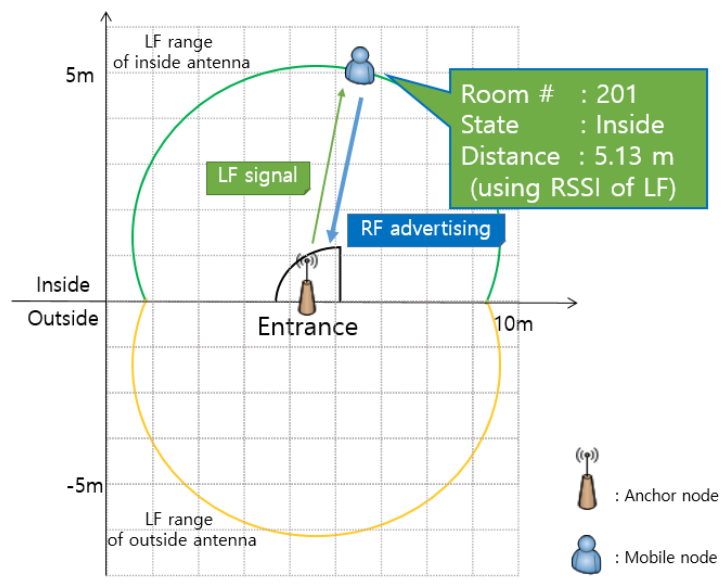
Figure 4. Situation and Distance awareness Between Mobile and Anchor node.